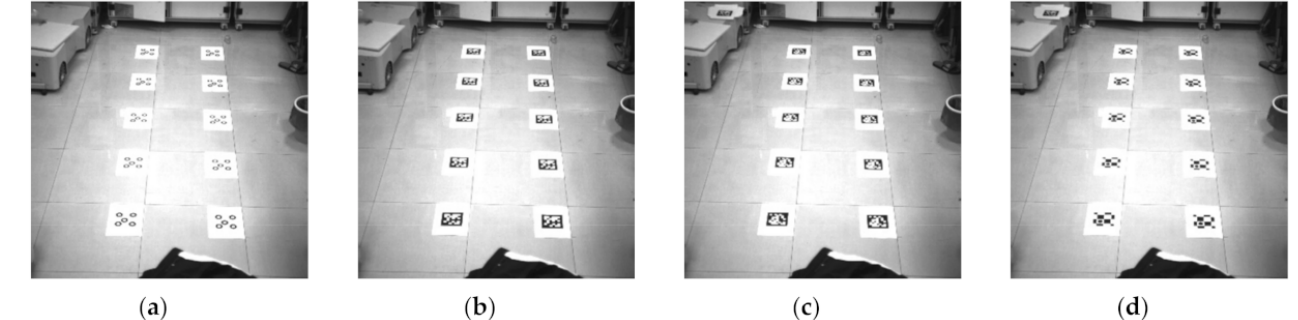
Figure 17. The positioning accuracy experiment of each marker at greater distance: ( a ) Circular ring; ( b ) AprilTag; ( c ) ArUco; ( d ) Checkerboard.